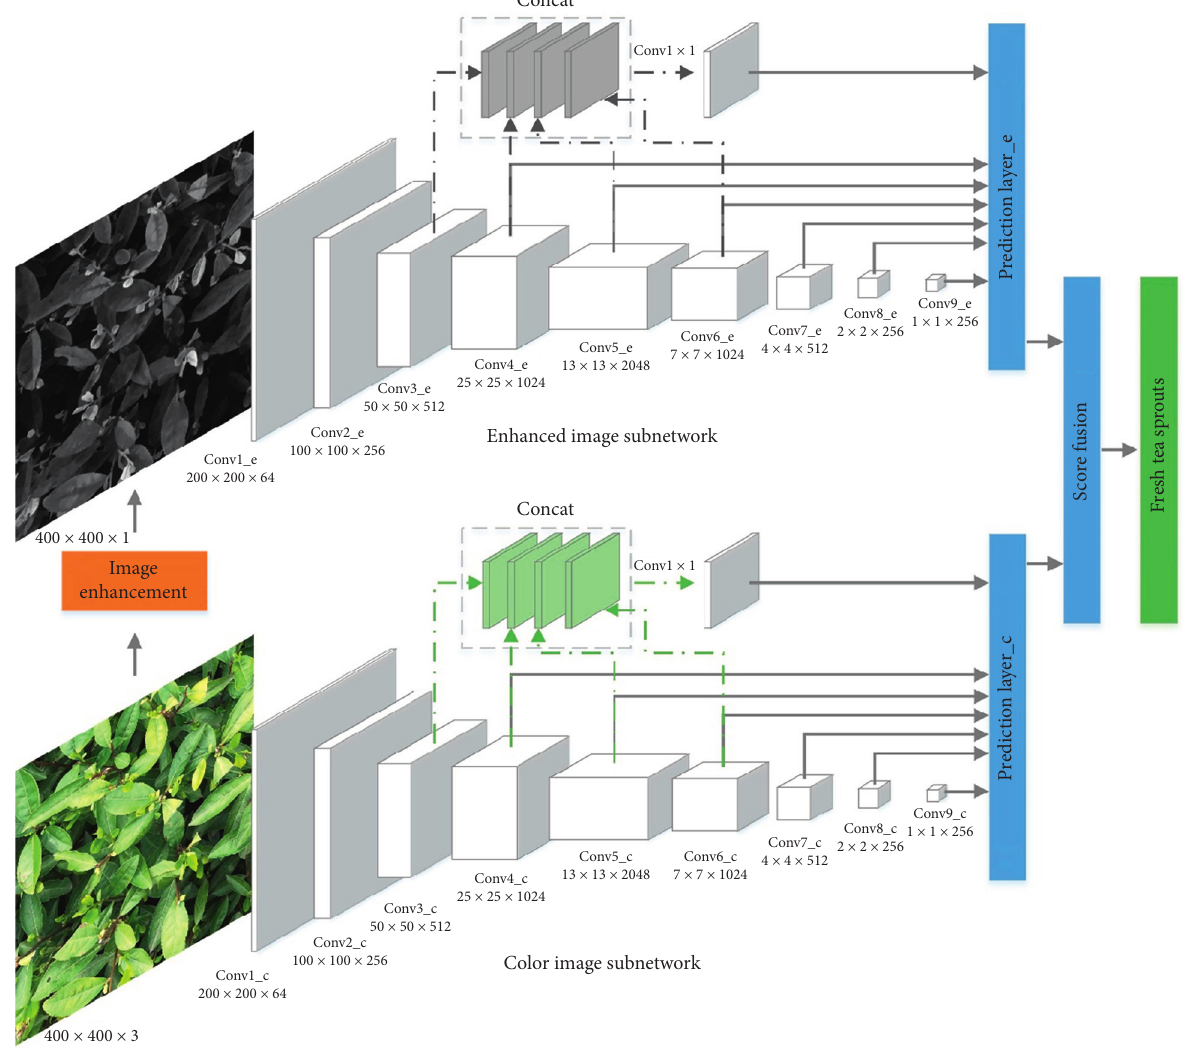
Figure 2: Network architecture of the proposed FTSD-IEFSSD method; the ResNet50 is used as the backbone of each subnetwork (conv1–5), and the extra convolutional layers and prediction layer follow the same design as the conventional SSD. An RGB-channel- transform-based image enhancement algorithm is proposed to get the enhanced image, which can provide more input information. The fusion features (enhanced conv3) are obtained from the semantic fusion of conv3–6, and the bilinear interpolation is employed in conv4–6 to align the same size of conv3. The score fusion is also employed to achieve the fresh tea sprouts